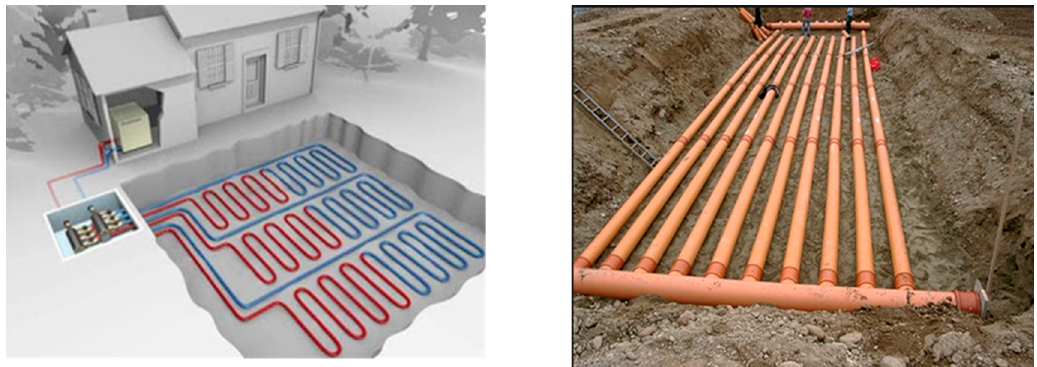
Figure 2. Collectors typical arrangement in a VLEGE facility.